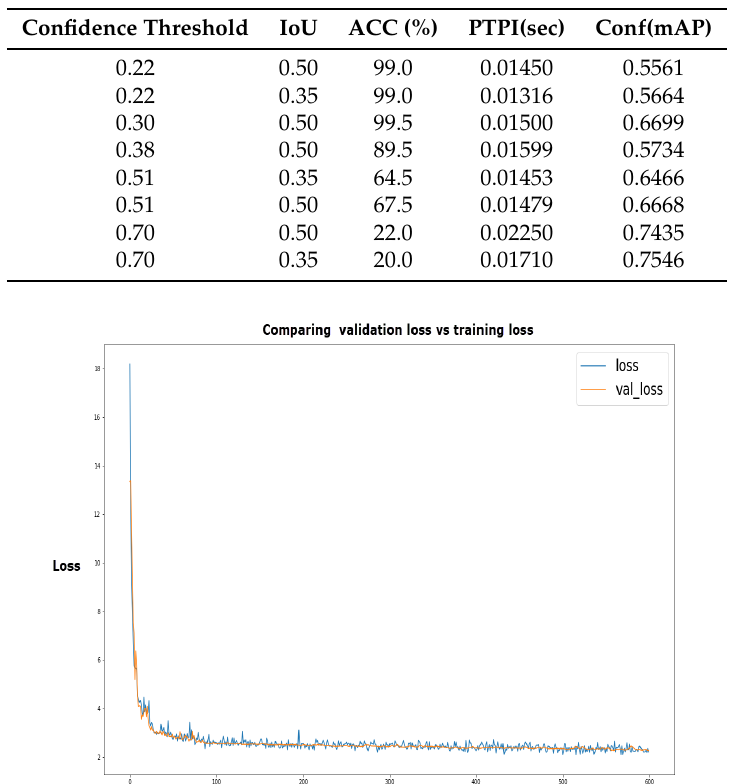
Table 3. Evaluation of confidence threshold and Intersection Over Union threshold (IoU) impacts on